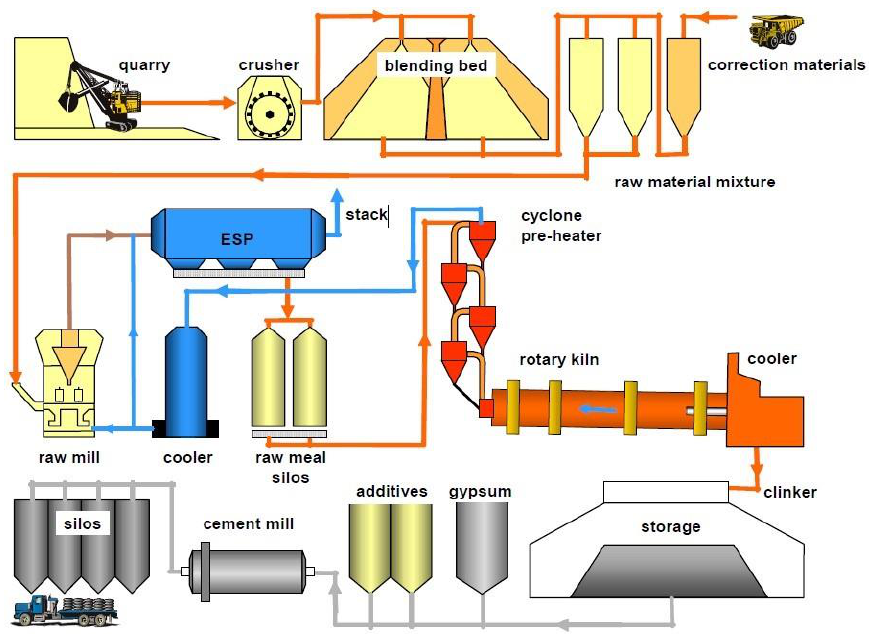
Figure 1. Schematic representation of the process of cement manufacturing. Reprinted with permis- sion from [43].